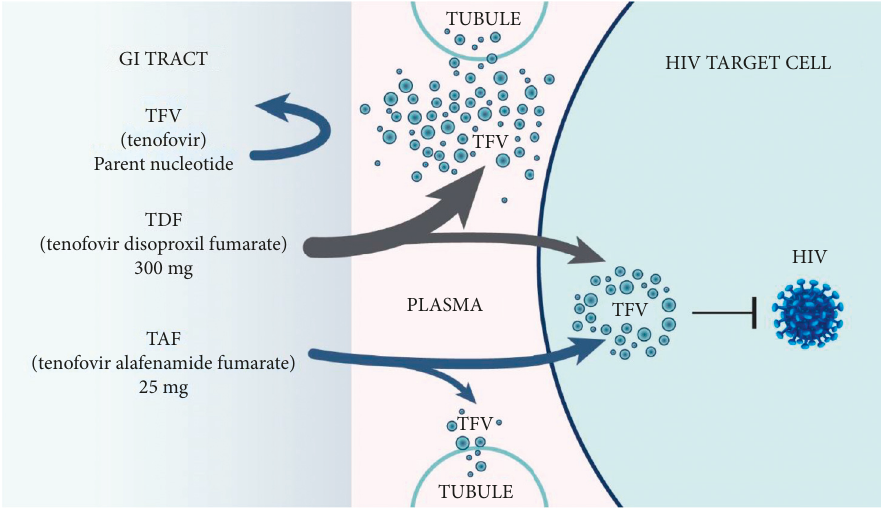
Figure 1: Higher TFV-DP levels in PBMCs with TAF vs TDF